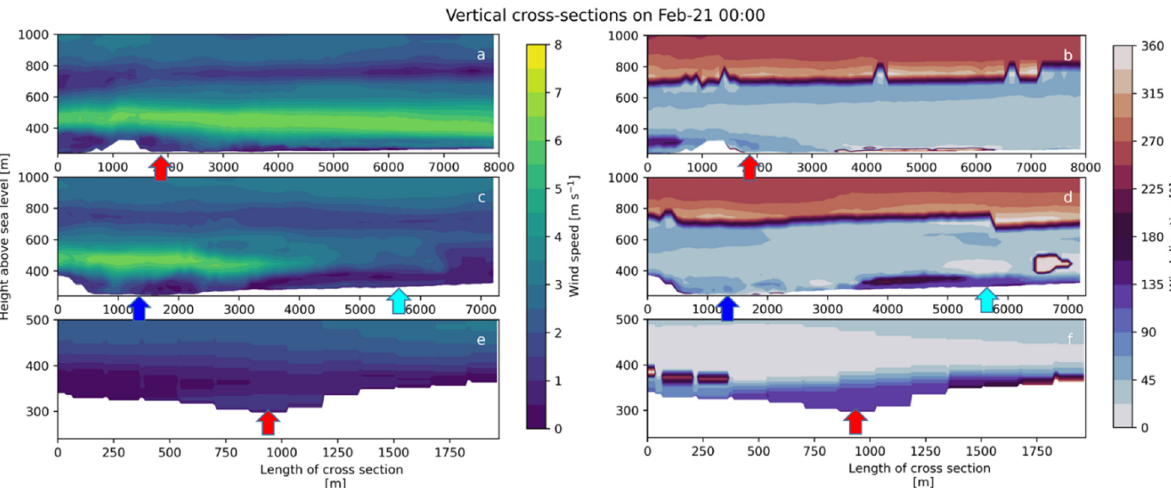
Figure 12. Vertical cross-sections of wind speed (left) and wind direction (right) along the Durance valley, moving down the valley from the right to the left ( a , b ; blue line in Figure 1c), along the Cadarache valley, moving down the valley from the right to the left ( c , d ; red line in Figures 1c and 11), and perpendicular to the Cadarache Valley, from the SW to the NE ( e , f ; cyan line in Figures 1c and 11). Red arrows indicate crossing points with the Cadarache valley cross-section, dark blue arrows indicate the crossing points with the Durance valley cross-section, and cyan shows where the cross-section perpendicular to the CV axis passes.